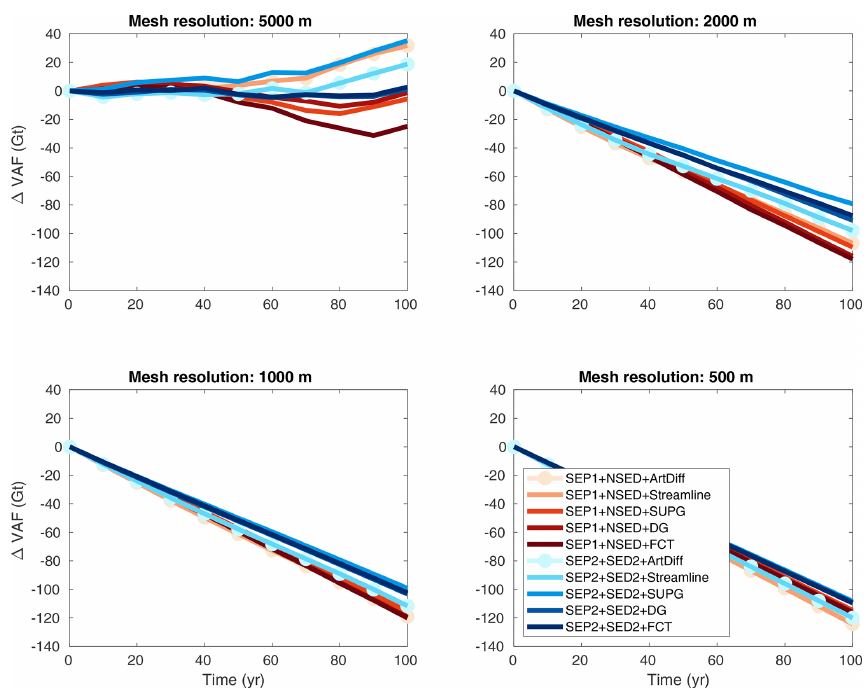
Figure 5. No external forcing experiment: evolution of volume above floatation change ( (cid:49) VAF) for different mesh resolutions and stabiliza- tion schemes (see legend). Two sets of parameterizations are employed: SEP1 + NSED and SEP2 + SED2.